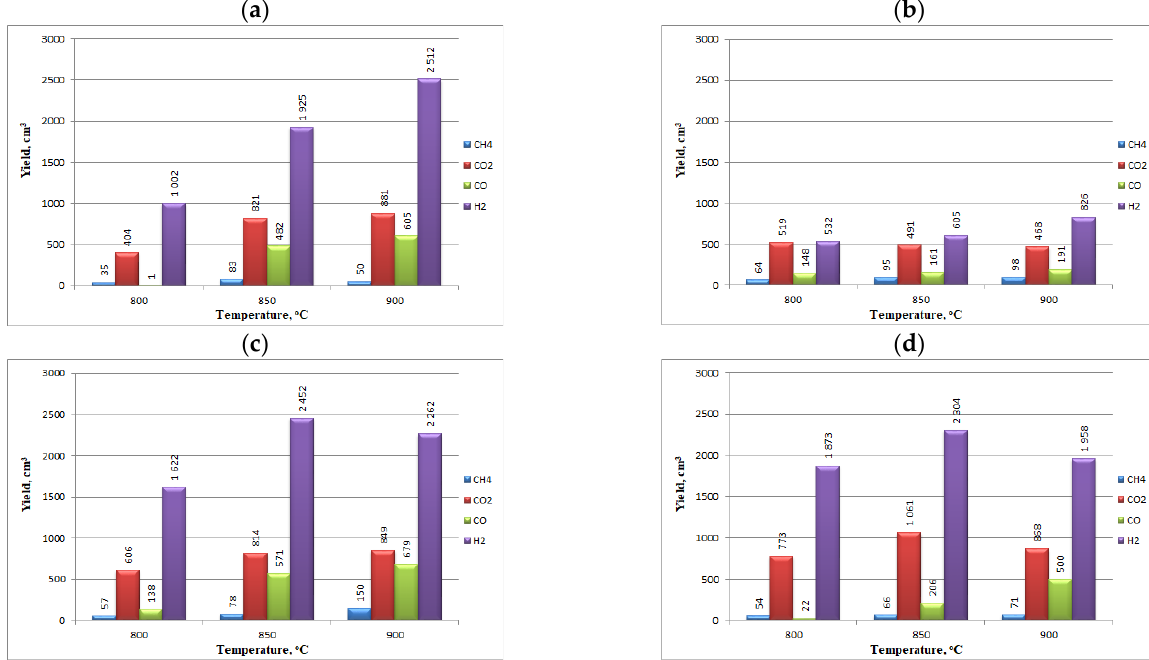
Figure 4. Yields of H 2 , CO, CO 2 , and CH 4 during the steam gasification of ( a ) tire char, ( b ) sewage sludge, ( c ) a 90:10 blend, and ( d ) a 67:33 blend. Table 3. Composition of the gas during steam gasification. Group of